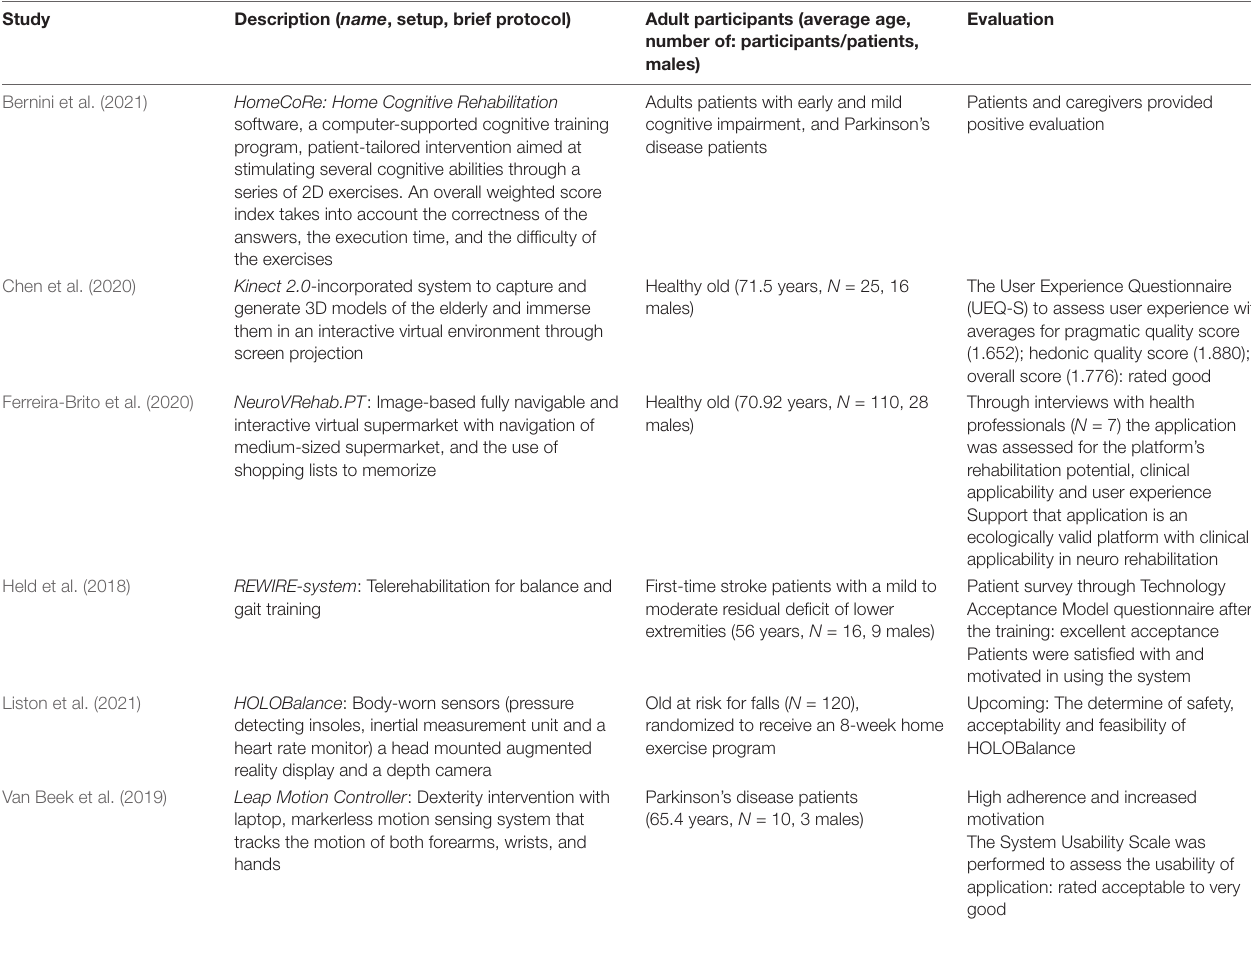
TABLE 1 | Overview of available user and expert evaluations for selected telerehabilitation exergames.